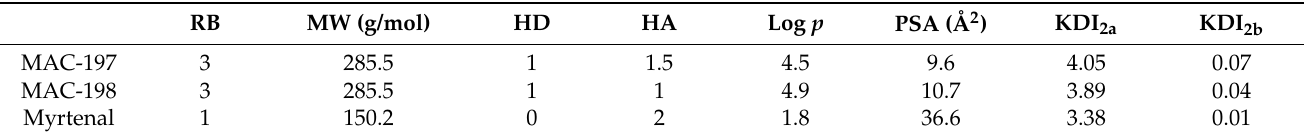
Table 1. The molecular descriptors and their corresponding Known Drug Indexes 2a and 2b (KDI 2a/2b ) for M and the